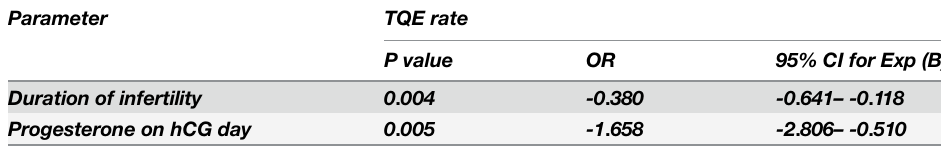
Table 3. Multivariate analysis of factors related to the TQE rate in conventional IVF cycles.